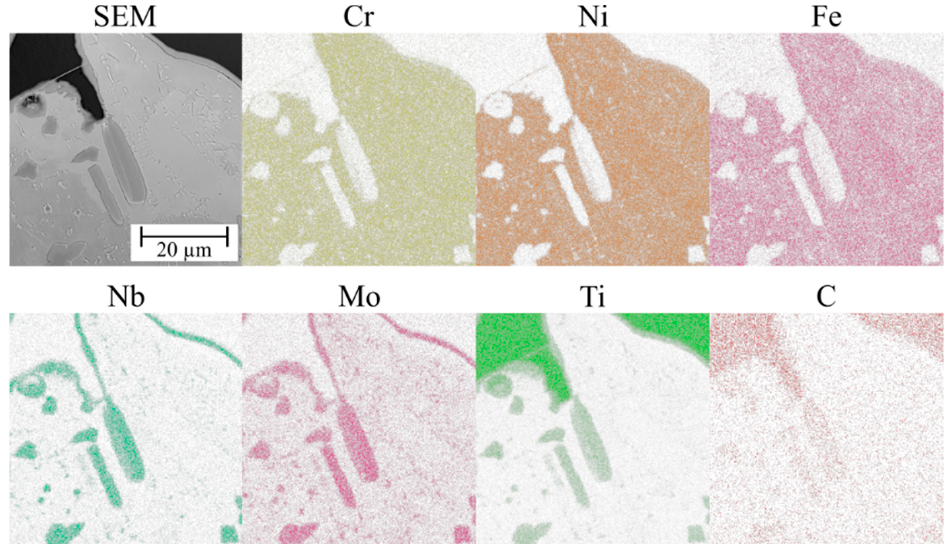
Figure 9. EDS maps of the overlap area of the composite Inconel 625/TiC coatings.